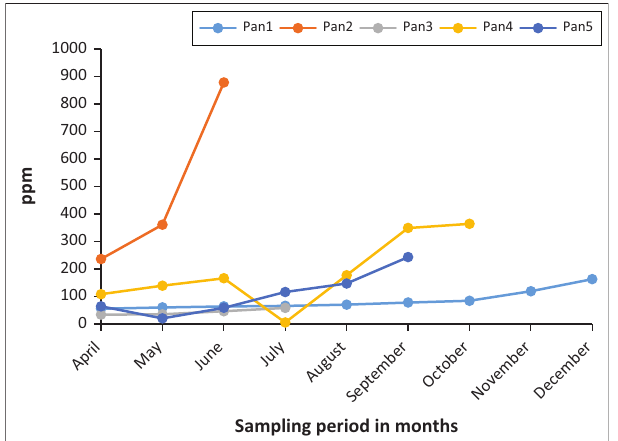
FIGURE 5: Salinity readings parts per million (ppm) at five pans in Gras-Holpan between April and December 2019, where Pans 2 and 3 were in the savanna biome and Pans 1, 4 and 5 in the Nama-Karoo biome.